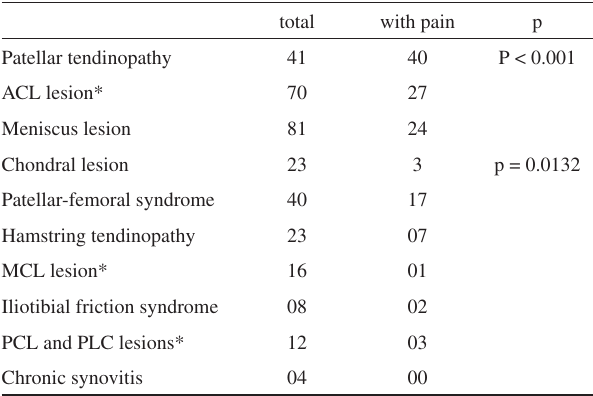
Table 2 - Prevalence of pain according to